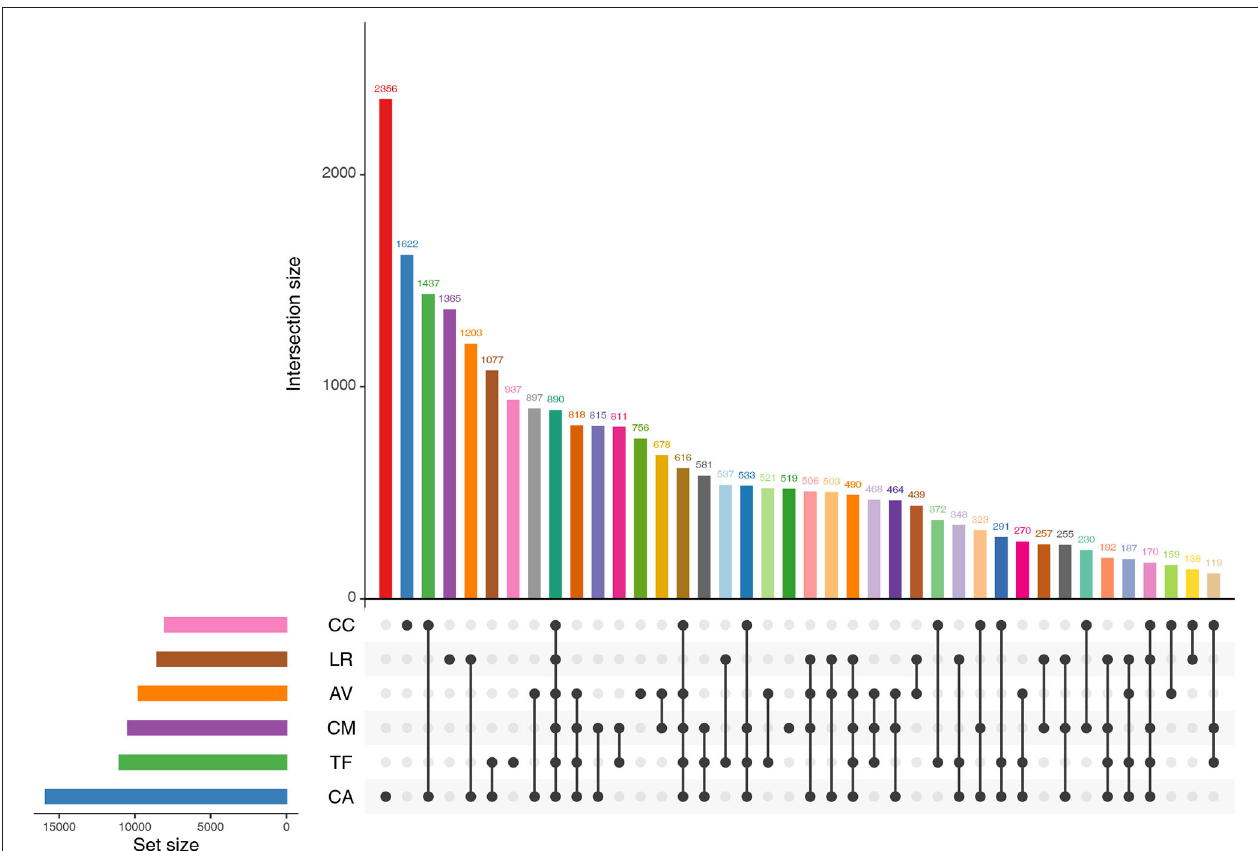
FIGURE 4 | Shared OTUs by the gut microbiota of different bird species. AV, demoiselle crane ( Anthropoides virgo ); CA, black swan ( Cygnus atratus ); CC, whooper Swan ( Cygnus cygnus ); CM, muscovy duck ( Cairina moschata ); LR, relict gull ( Larus relictus ); TF, ruddy shelduck ( Tadorna ferruginea ).